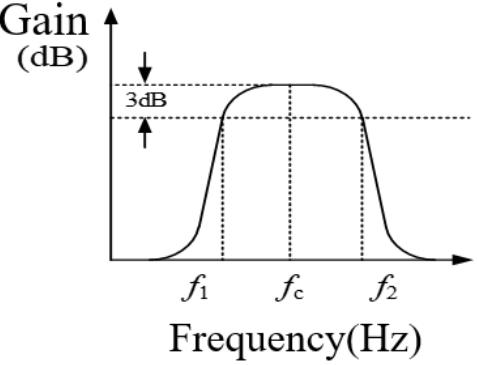
Figure 19. Filter frequency response curve of band-pass filter.